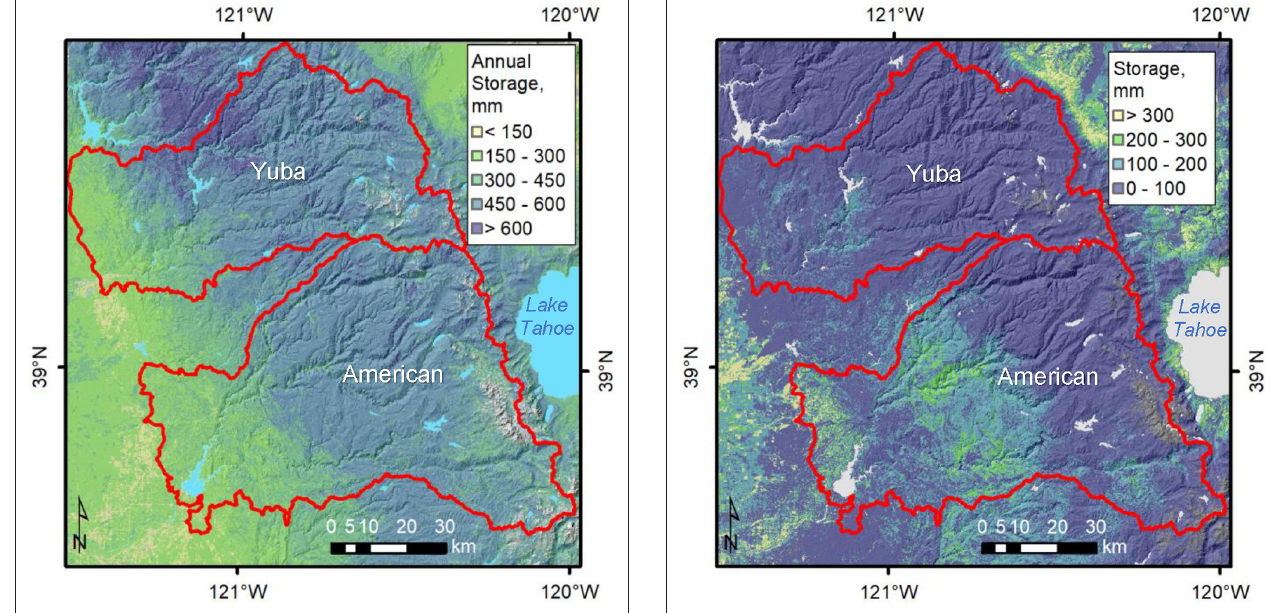
∼ 175 mm year − 1 for a 25–75% basal area reduction ( Figure 3